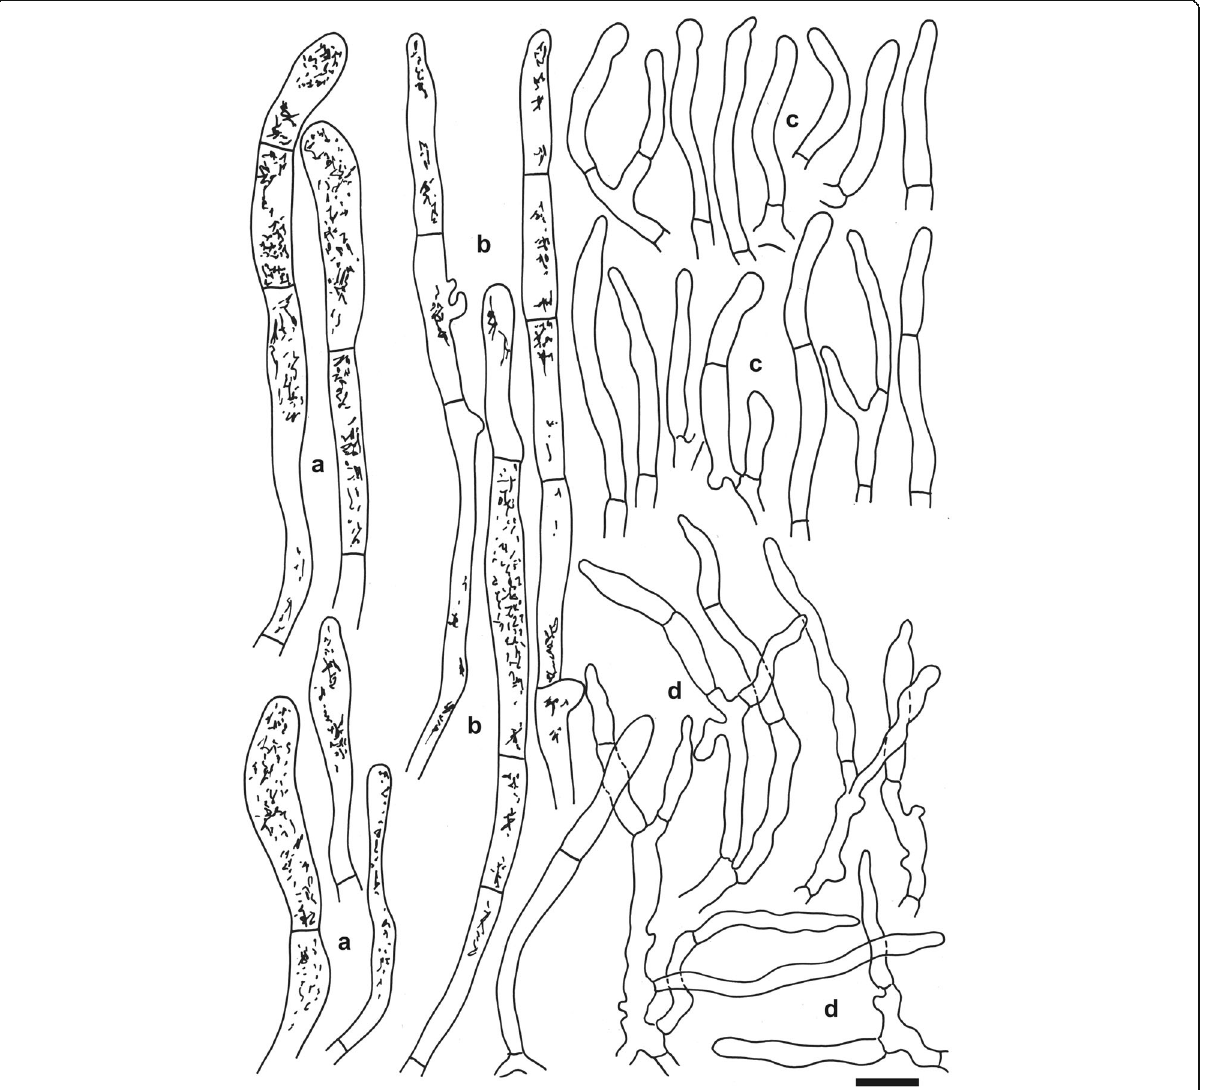
Fig. 3 Russula dryadicola (IB 1997/0750, neotype). Microscopic features of the pileipellis. a . Pileocystidia near the pileus centre. b . Pileocystidia near the pileus margin. c . Hyphal terminations in the pileus centre. d. Hyphal terminations near the pileus margin. Contents of cystidia are as observed in Congo red. Bars = 10 μ m. Drawings: S.A. &